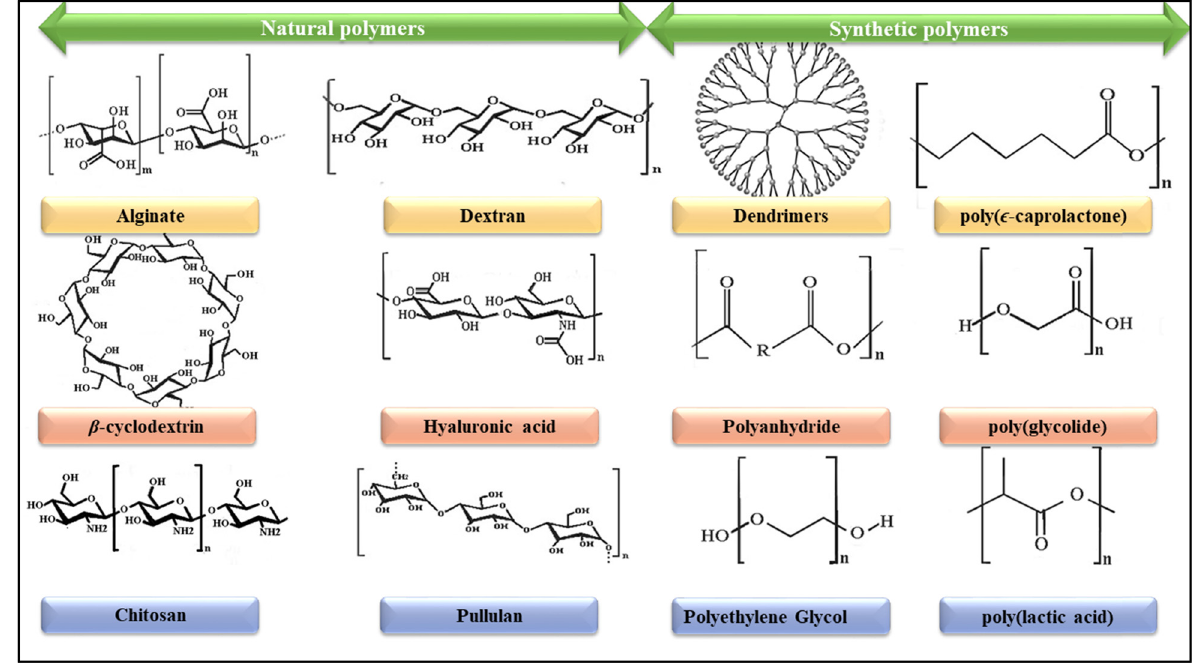
Figure 3: Few examples of natural and synthetic